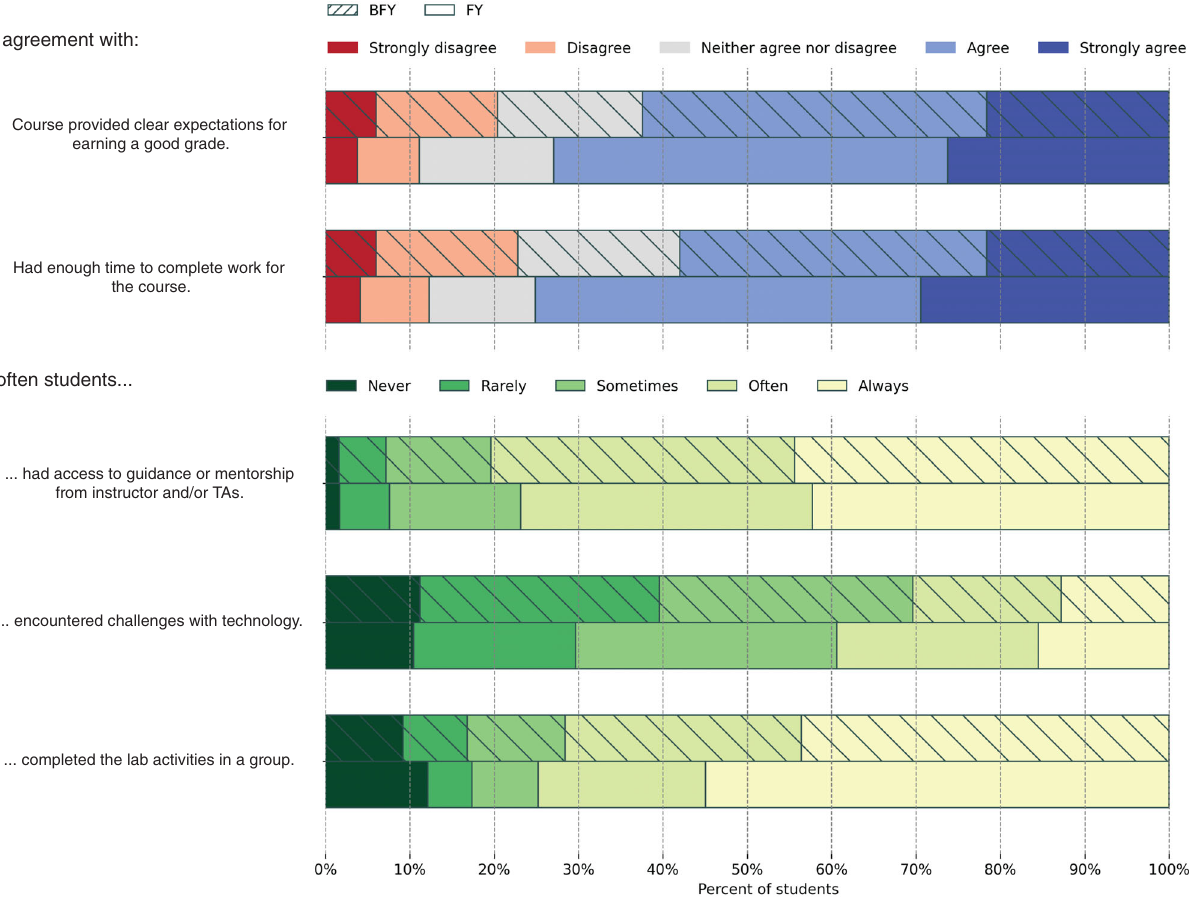
FIG. 4. Student responses to questions about the course environment. Two Likert scale questions show the percent of students who ranked their agreement with the statements from strongly disagree (dark red) to strongly agree (dark blue). Three frequency scale questions show the percent of students who never, rarely, sometimes, often, and always (progressively lighter shades of green) had certain experiences in their course, ordered by the percent of FY students who responded never. The percentages shown are the percent of students in BFY (hatched, N ¼ 250 ) or FY (plain, N ¼ 4565 )